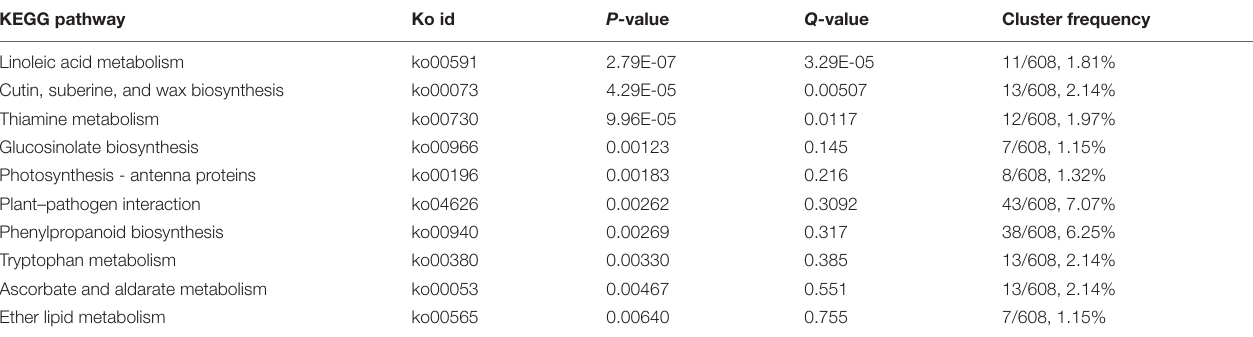
TABLE 1 | Top 10 of Kyoto Encyclopedia of Genes and Genomes (KEGG) enrichment